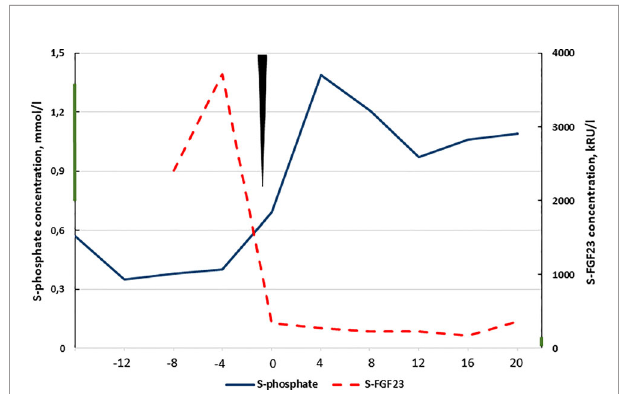
FIGURE 2 | Timeline showing serum phosphate and FGF23 (C-terminus) concentrations at diagnosis and postoperatively. Time of surgery is marked with the black triangle and X-axis presents the time in months relative to surgery. Reference ranges are 0.76-1.41 mmol/l, and 26-110 kRU/l are marked to the y-axes with a bar, respectively.